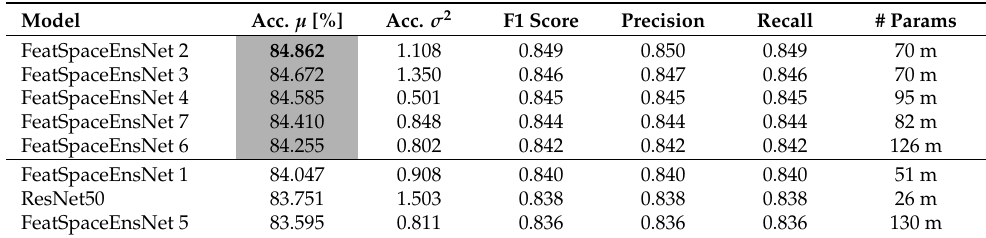
Table 3. Performance of the feature space ensemble models applied with the corresponding number of parameters.